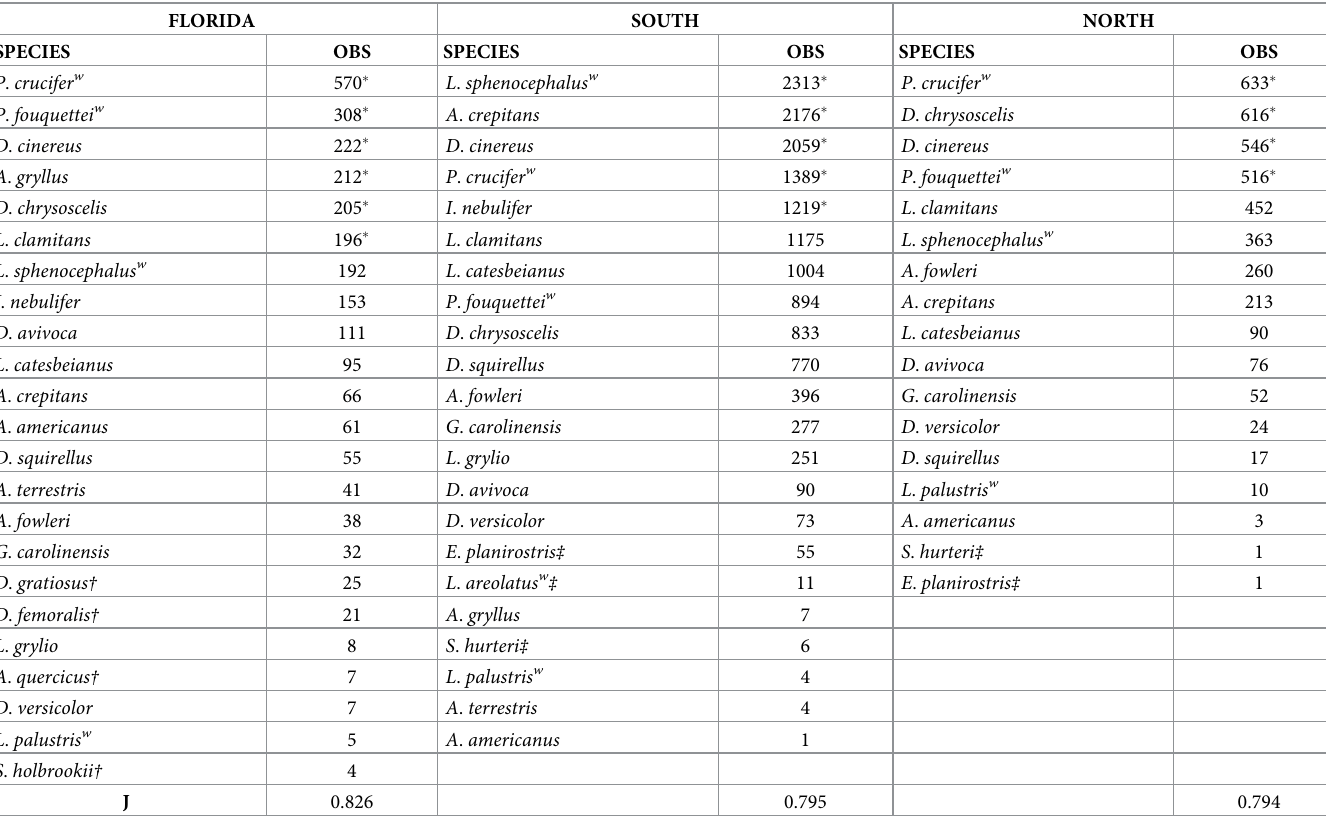
Table 5. Species abundance by LAMP